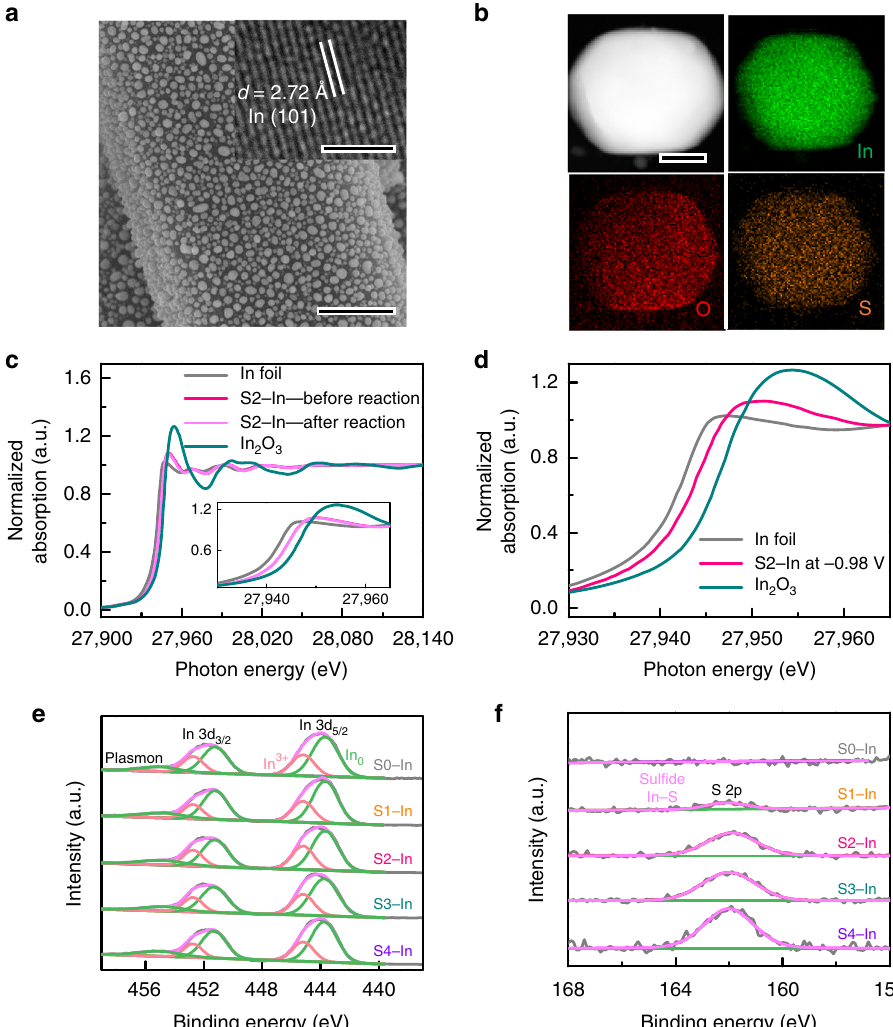
Fig. 2 Characterizations of morphologies and chemical states for S − In catalysts. a SEM image and HRTEM image (insert) of S2 − In catalyst. b STEM image of S2 − In catalyst and the corresponding EDS elemental mapping. c In K-edge XANES spectra for S2 − In catalyst before and after reaction. d In situ In K-edge XANES spectra for S2 − In catalyst at − 0.98 V versus RHE. e and f In 3d and S 2p XPS spectra of S − In